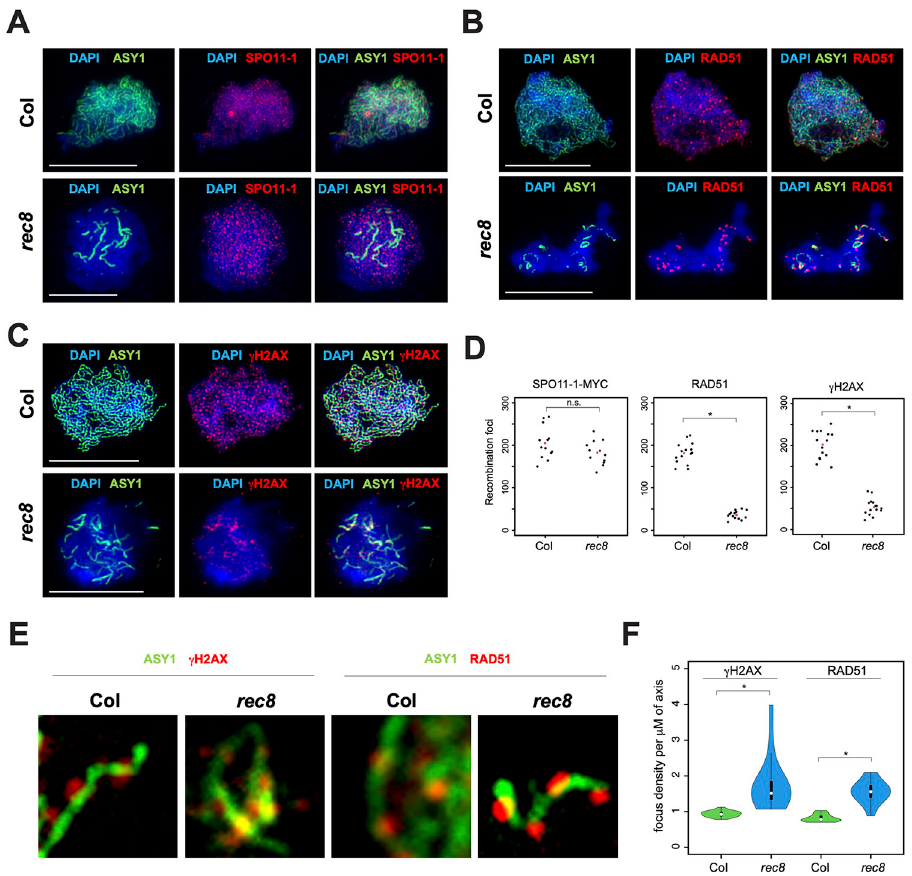
Fig 4. SPO11-1, RAD51 and γ H2AX staining in wild type and rec8 . ( A ) Staining of SPO11-1-MYC (red) and ASY1 (green) in wild type (Col) and rec8 . Chromatin is stained with DAPI (blue). Scale bars = 10 μ M. ( B ) Staining of RAD51 (red) and ASY1 (green) in wild type (Col) and rec8 . Chromatin is stained with DAPI (blue). Scale bars = 10 μ M. ( C ) Staining of γ H2AX (red) and ASY1 (green) in wild type (Col) and rec8 . Chromatin is stained with DAPI (blue). Scale bars = 10 μ M. ( D ) Plot showing counts of SPO11-1-MYC, RAD51 or γ H2AX foci in wild type (Col) and rec8 . Black dots represent individual measurements, and red dots represent mean values. Counts of RAD51 and γ H2AX foci are taken from Lambing et al. 2020. A Mann-Whitney-Wilcoxon test was used to compare SPO11-1-MYC or RAD51 foci count between wild type (Col) and rec8 . “ � ” indicates a statistically significant difference. “n.s.” indicates a non- statistically significant difference. ( E ) Co-staining of ASY1 (green) with RAD51 or γ H2AX (red) in early prophase I in wild type (Col) and rec8 . ( F ) Violin plot representing the distribution of RAD51 or γ H2AX focus density per μ m of axis between nuclei in wild type (Col) and rec8 . A Mann-Whitney-Wilcoxon test was performed to test for significance. “ � ” indicates a statistically significant difference.